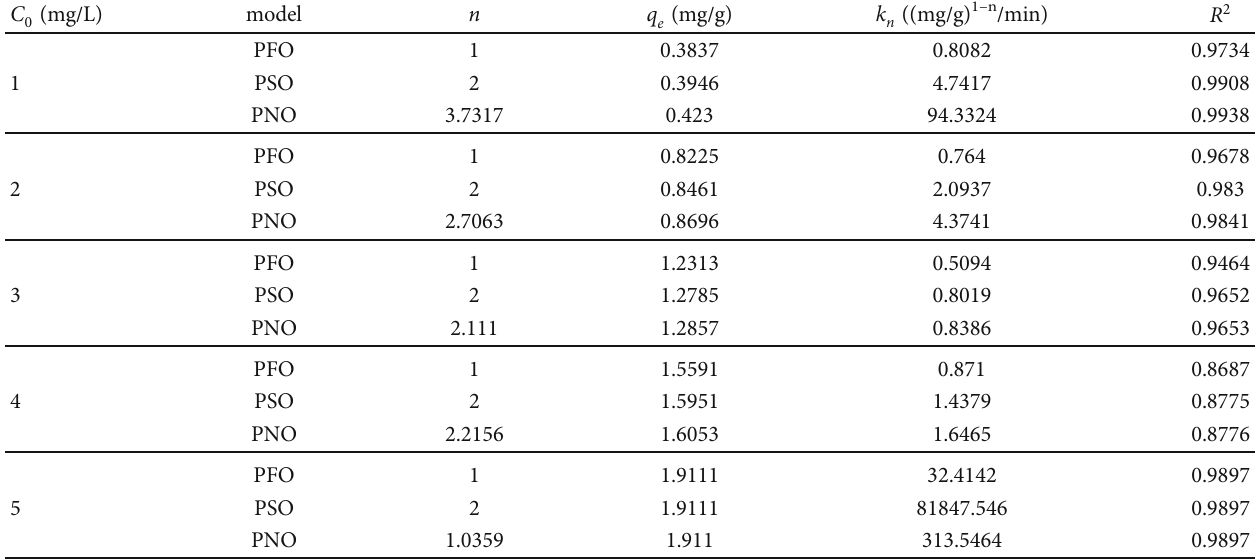
Table 4: Kinetic parameters and coe ffi cients of determination for the PFO, PSO, and PNO models of fl uoride adsorption by Xant-Al for initial fl uoride concentrations of 1, 2, 3, 4, and